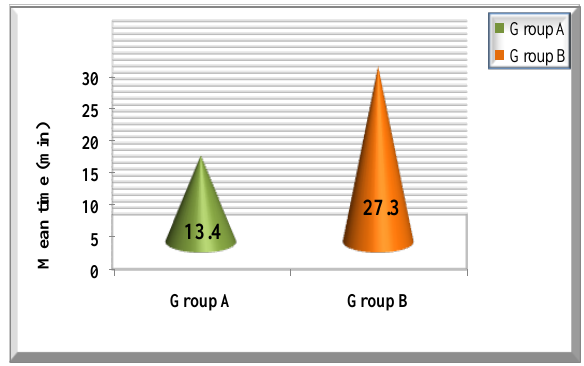
Figure 9: Mean time of operation compared in between study